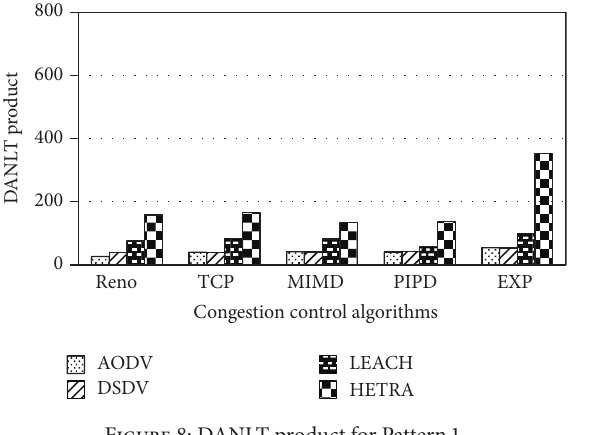
Figure 8: DANLT product for Pattern 1.